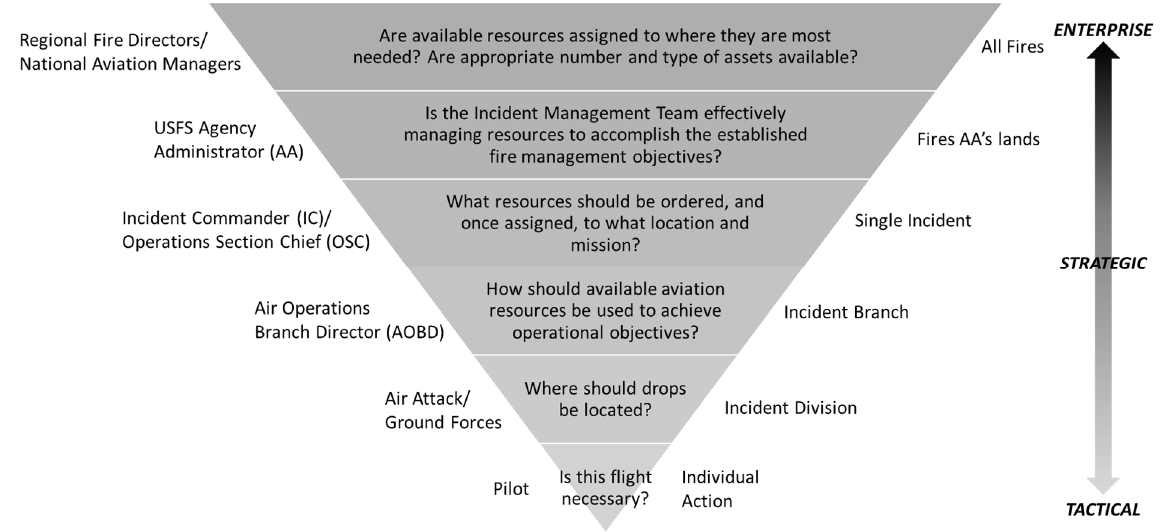
Figure 2. Key positions and related duties associated with ensuring safe and effective aviation use in fire management. Example questions in the inverted triangle scale the key risk management question “Is this flight necessary?” up to each broader position to examine the interdependence of these duties from tactical, through strategic, and up to enterprise scale.